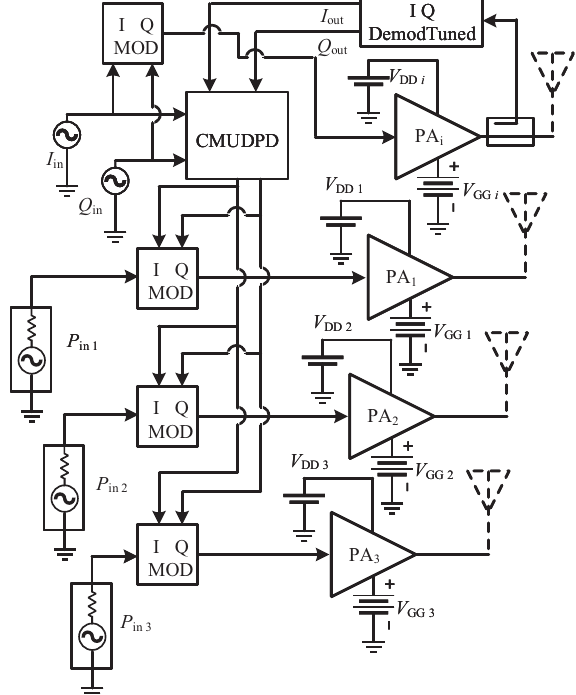
Figure 4. Schematic diagram of the simulation circuit.